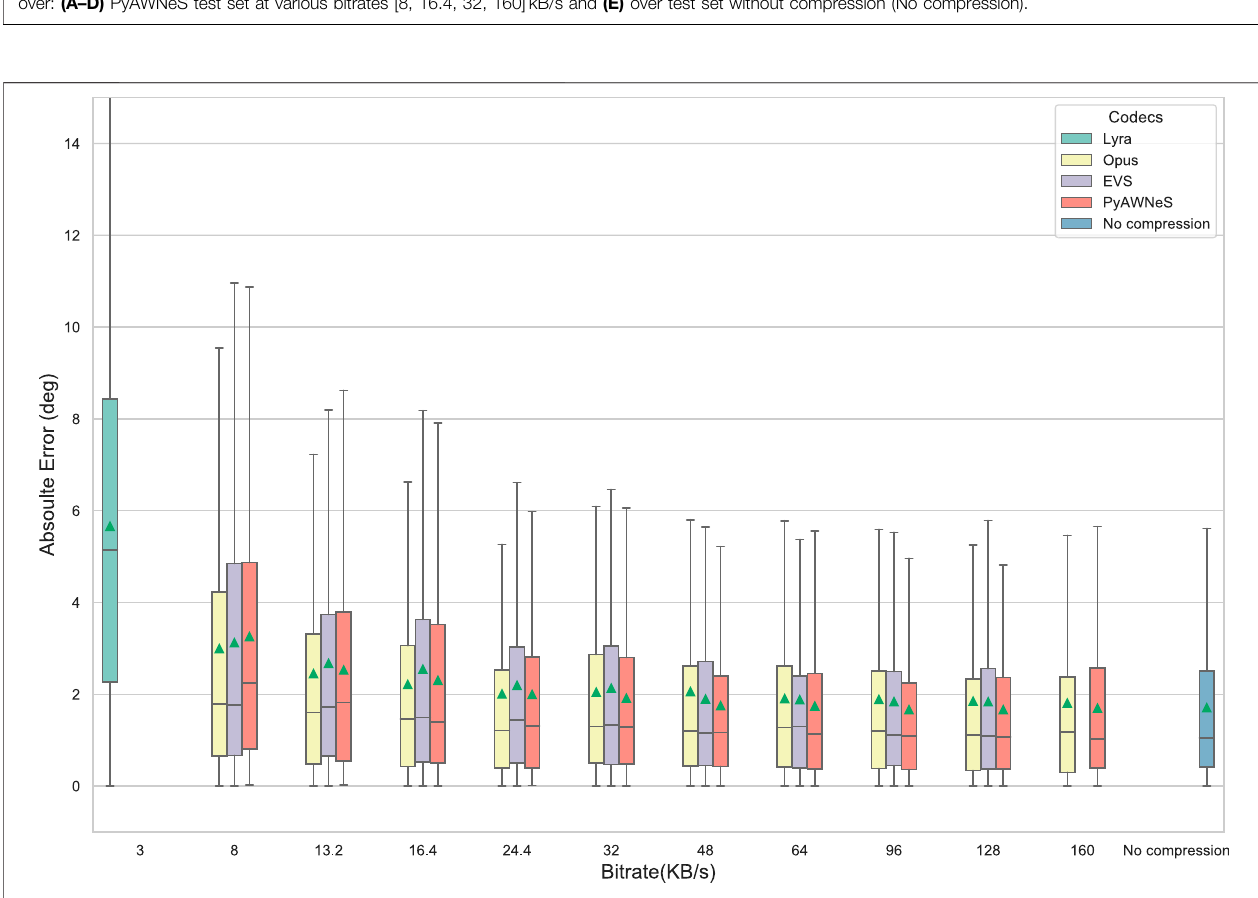
FIGURE 7 | Absolute Error versus increasing bitrate when employing different codecs performed by the model trained without compression ( w / o codec ) on a test set including similarly encoded signals. The green triangle in each boxplot shows the MAE (deg).